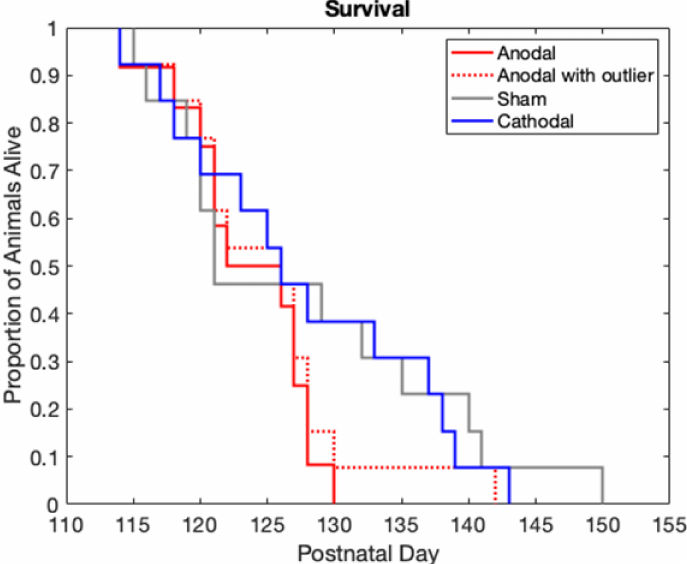
Figure 7. Survival vs. age by group. Note the high number of animals who die around P125–P130 in the solid red anodal treatment